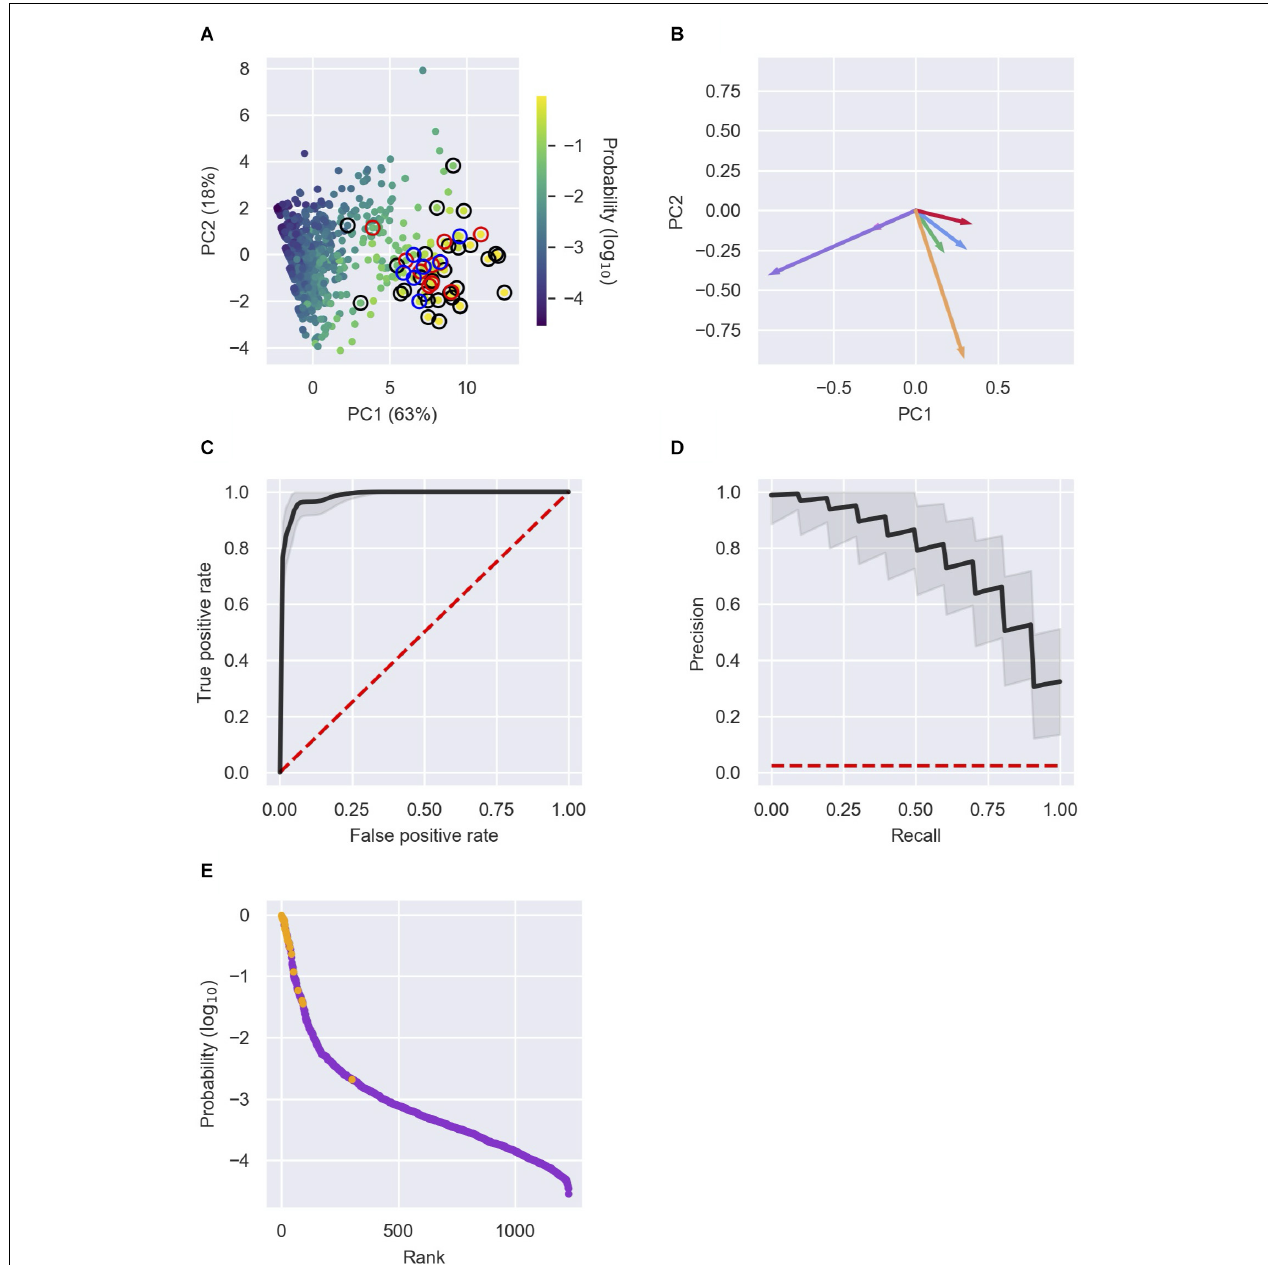
FIGURE 3 | Detection of novel sRNAs. (A) Principal component analysis (PCA) of RNAs characterized by the six features. The RNAs (dots) are plotted in two dimensions, using their projections onto the first two principal components. Each RNA in the data is colored by its sRNA probability, as assigned by the logistic regression analysis. Colored circles surrounding the dots represent: a well-established sRNA marked in Supplementary Table 1 by 1 (black), a recently discovered sRNA listed in Table 2A (red) or a newly discovered sRNA listed in Table 2B (blue). (B) Contribution of the features to PC1 and PC2. The vectors represent the coefficients of the features in each PC: Total number of chimeric fragments (green), number of unique interactions (blue), SIC score (red), U-tract length (orange), median number of interactions of interactors (pink), median SIC score of interactors (purple). (C,D) Receiver operating characteristic (ROC) curve (C) and precision–recall (PR) curve (D) showing the high predictive power of the logistic regression model. Shown in black are the curves obtained from the mean probabilities of 10,000 iterations of the logistic regression, and the curves of individual iterations in the range of one standard deviation around the curve of mean probabilities. The curves are compared to the expected curve of a random classifier (red dashed line). The area under curve (AUC) of the ROC curve is 0.98 ± 0.01. (E) Known sRNAs and “other RNAs” (colored orange and purple, respectively) were ranked by their computed sRNA scores. Highly ranked RNAs, yet unknown as sRNAs, are predicted as putative novel sRNAs. Presented results are for the data set of stationary phase RIL-seq experiment. Results for the exponential phase data sets are shown in Supplementary Figures 4 , 5 .